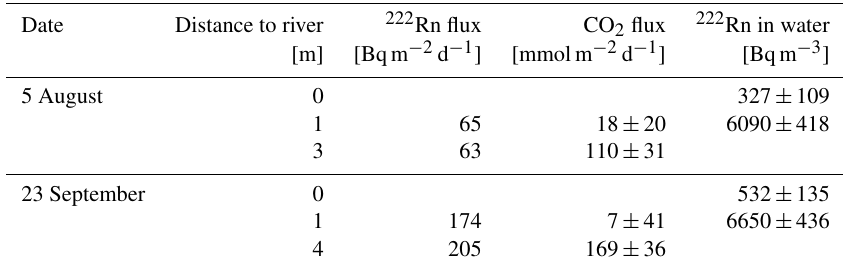
Table 2. Flux of radon measured as 222 Rn increase in static chambers compared to CO 2 flux measured in the same chambers and radon concentration determined as detected activity [Bqm − 3 ] in the groundwater sampled in wells directly beside the chambers as well as in the river water (0m